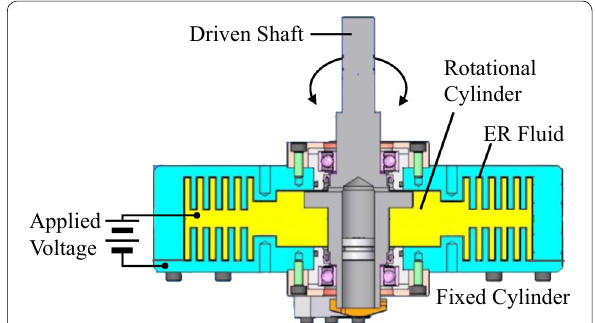
Fig. 3 Sectional view of the ER brake